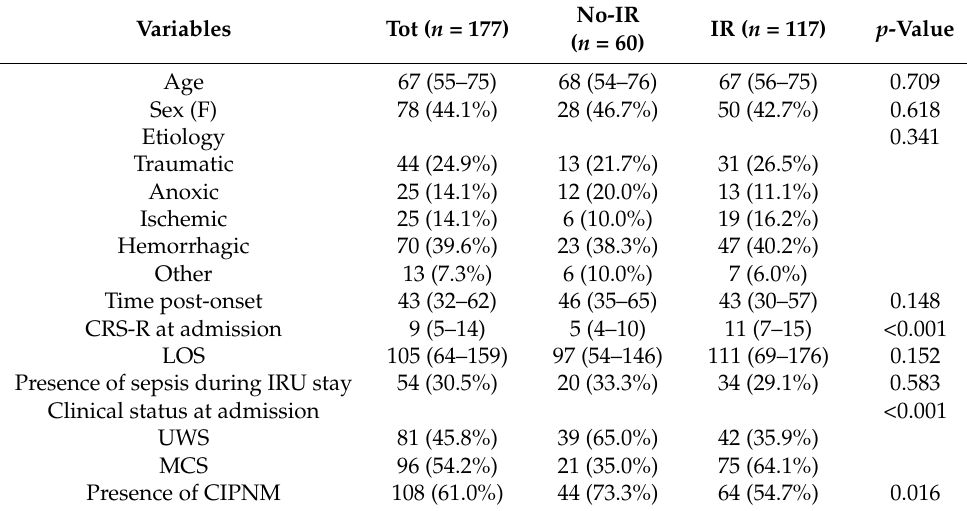
Table 1. Characteristics of the study sample and comparison between not-improved responsiveness (No-IR) and improved responsiveness (IR)